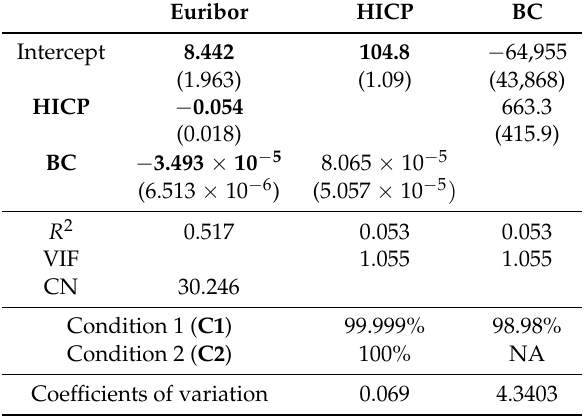
Table 10. Estimations by OLS of model (13) and its corresponding auxiliary regressions (estimated standard deviation in parenthesis and coefficients significantly different from zero in bold).